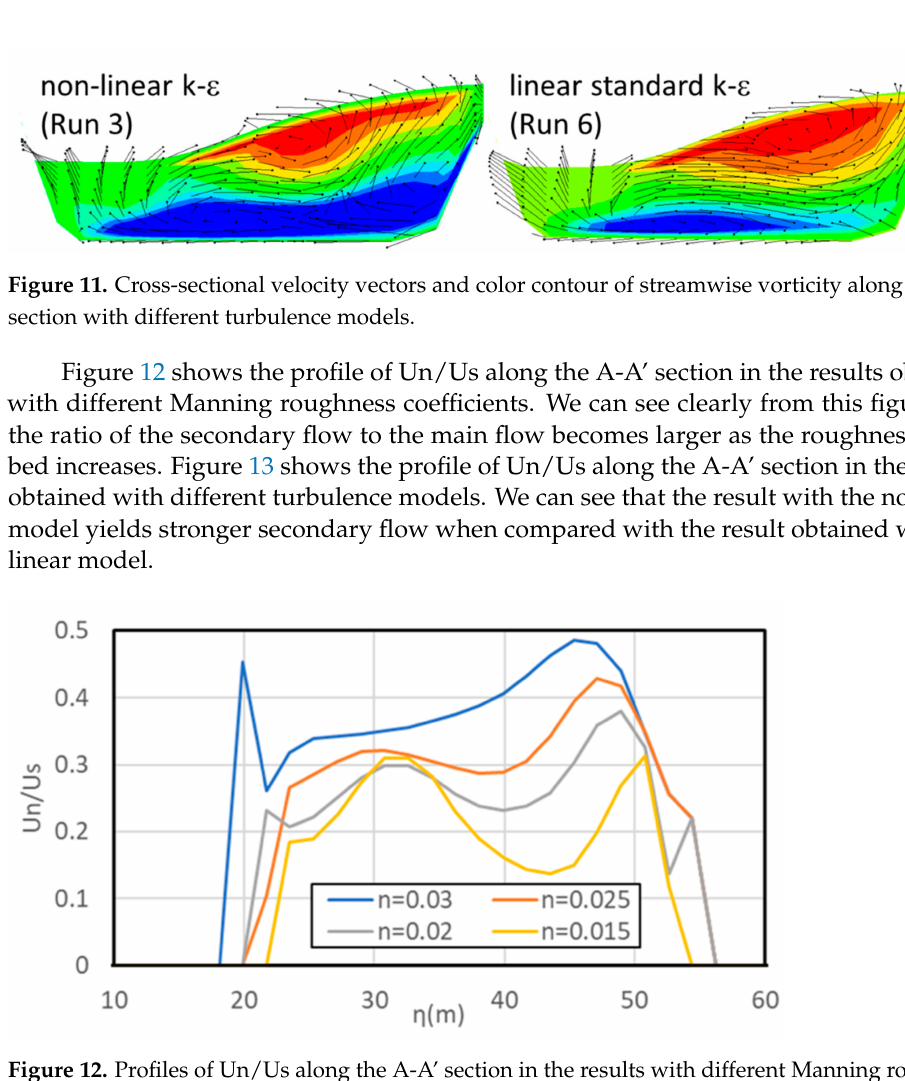
Figure 12. Profiles of Un/Us along the A-A’ section in the results with different Manning roughness coefficients (Run 1, 3, 4, and 5) (Us: flow in the channel direction near the bottom, Un: lateral flow toward the inner bank near the bed).